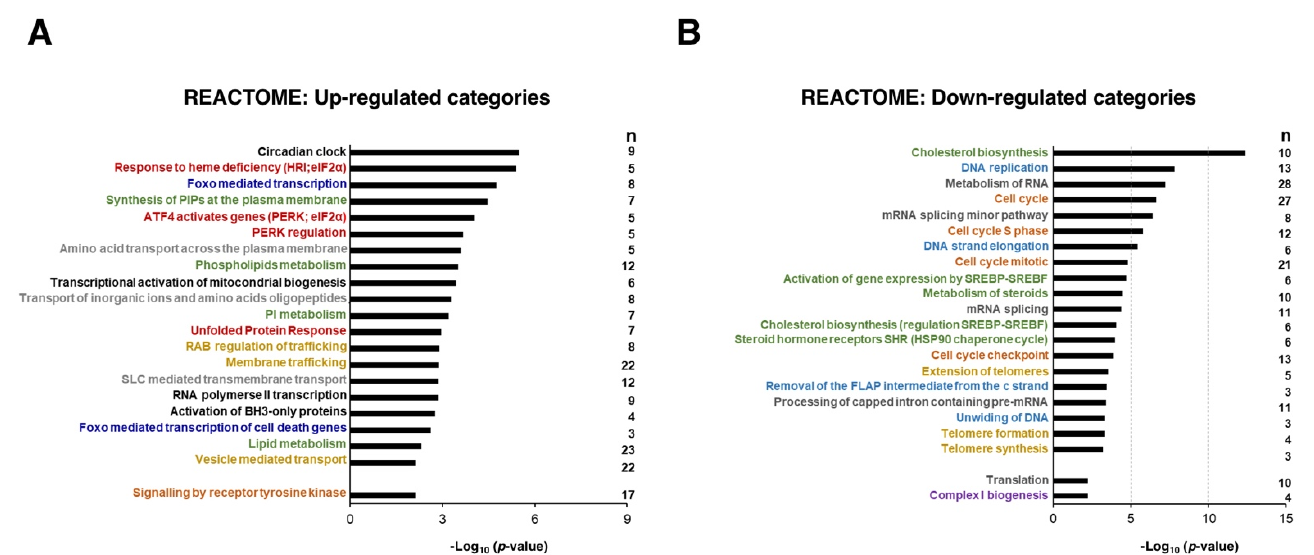
Figure 3. Overrepresentation analysis (ORA) of commonly upregulated ( A ) and downregulated ( B ) genes in both HepG2 and SNU423 cells treated with Sorafenib (10 µM, 12 h) using the REACTOME database. The 20 categories with better p -values as well as a few selected ones (e.g., signaling by receptor tyrosine kinase, translation, complex I biogenesis) are shown. The categories of related biological processes are labeled in the same color. The number of genes with p -value < 0.001 in the different categories ( n ) is depicted. The p -values were − log 10 transformed.